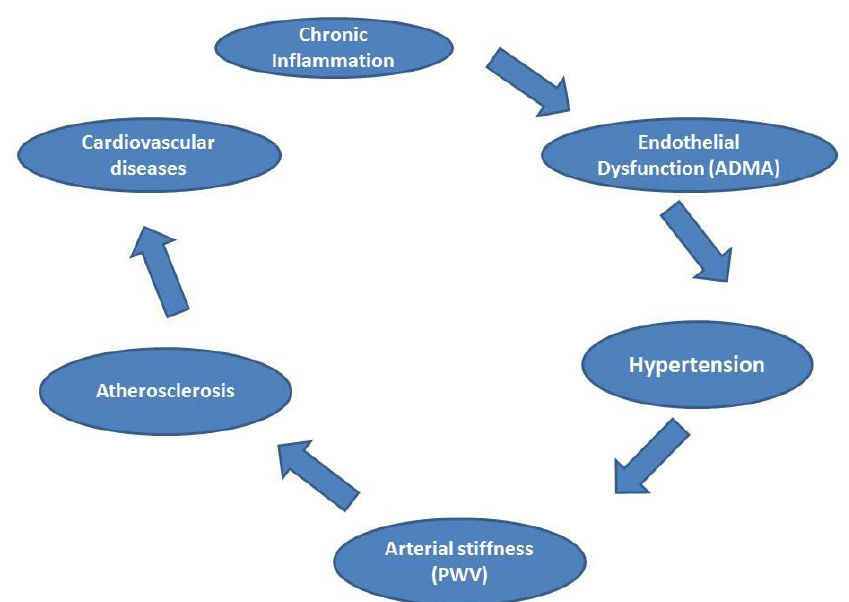
Figure 1. The relationship between autoimmune diseases and vascular function. Legend: asymmetric dimethylarginine (ADMA), pulse wave velocity (PWV).